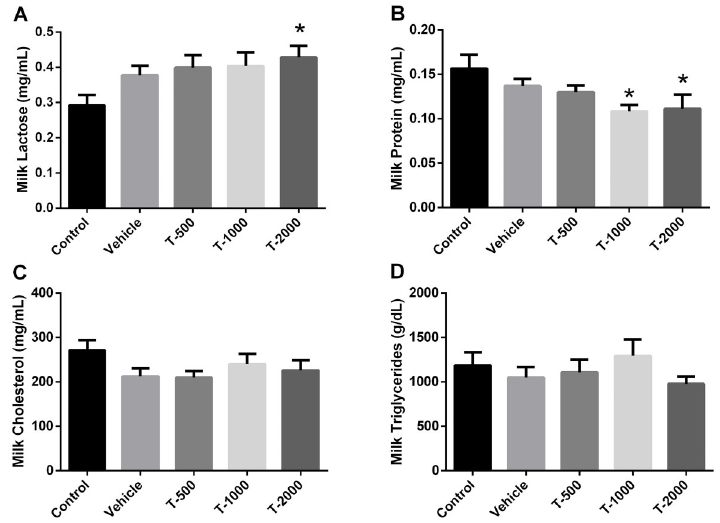
Figure 2. Effect of valerian treatment on milk composition of mothers. Values of ( A ) lactose (F(4,75)=0.1682, *P=0.048), ( B ) total protein (F(4,71)=4.89, *P=0.046), ( C ) cholesterol (F(4,63)=4.833, P=0.195), and ( D ) triglycerides (F(4,64)=1.775, P=0.564) in the control (1 mL distilled water), vehicle (1 mL distilled water, 20% of glycerol), T-500 (500 mg (cid:1) kg – 1 (cid:1) day – 1 of valerian), T-1000 (1000 mg (cid:1) kg – 1 (cid:1) day – 1 of valerian), and T-2000 (2000 mg (cid:1) kg – 1 (cid:1) day – 1 of valerian) groups. *P o 0.05 compared to control (one-way ANOVA/Dunnett ’ s